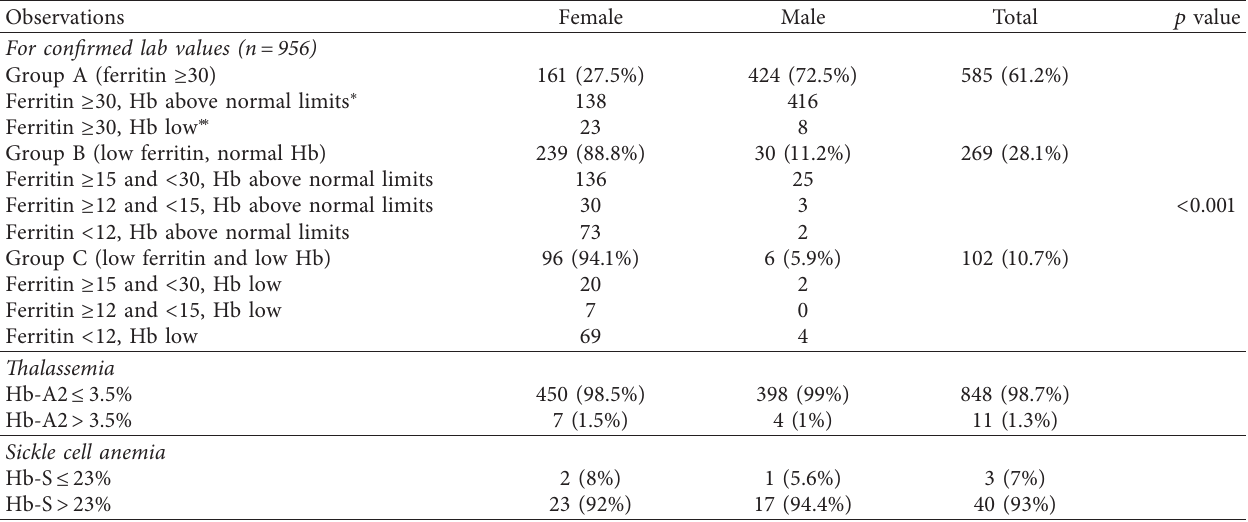
Table 3: Observations based on hematological profile—full Cohort, all